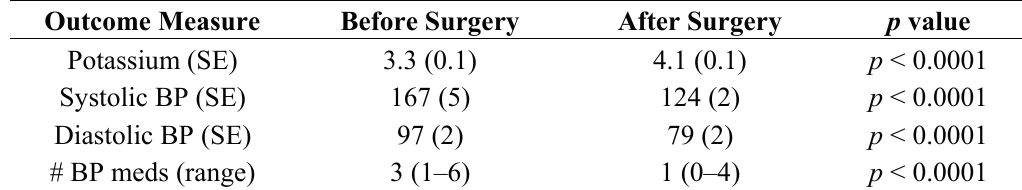
Table 3. Clinical and laboratory findings in patients before and after adrenalectomy. After surgery, blood pressure decreased on fewer antihypertensive medications, and potassium normalized. Potassium presented as mEq/L; BP as mmHg. Outcome Measure Before Surgery After Surgery p value Potassium (SE) 3.3 (0.1) 4.1 (0.1) p < 0.0001 167